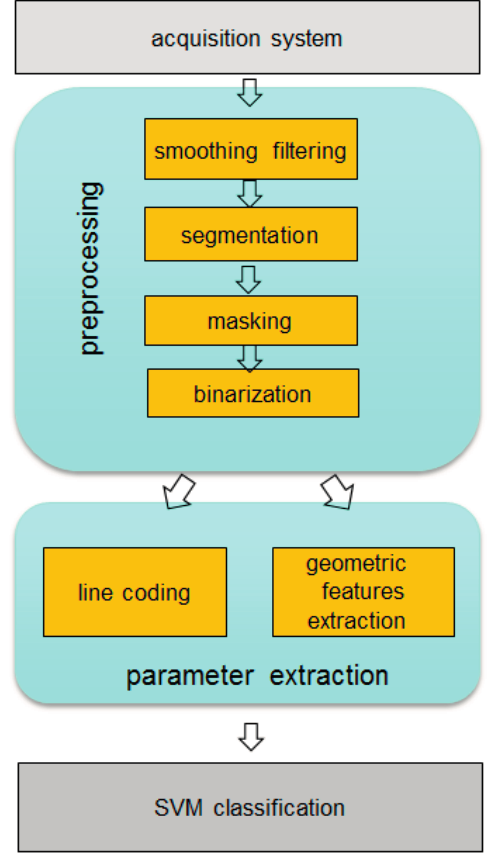
Figure 7. Preprocessing and parametrization